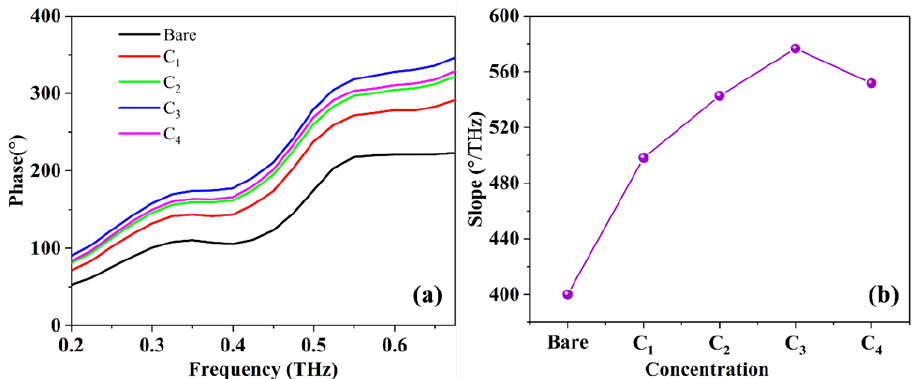
Figure 6. ( a ) Phase spectrograms of different OVA concentrations. ( b ) Graph of the change in the slope of the phase curve with the concentration of OVA.